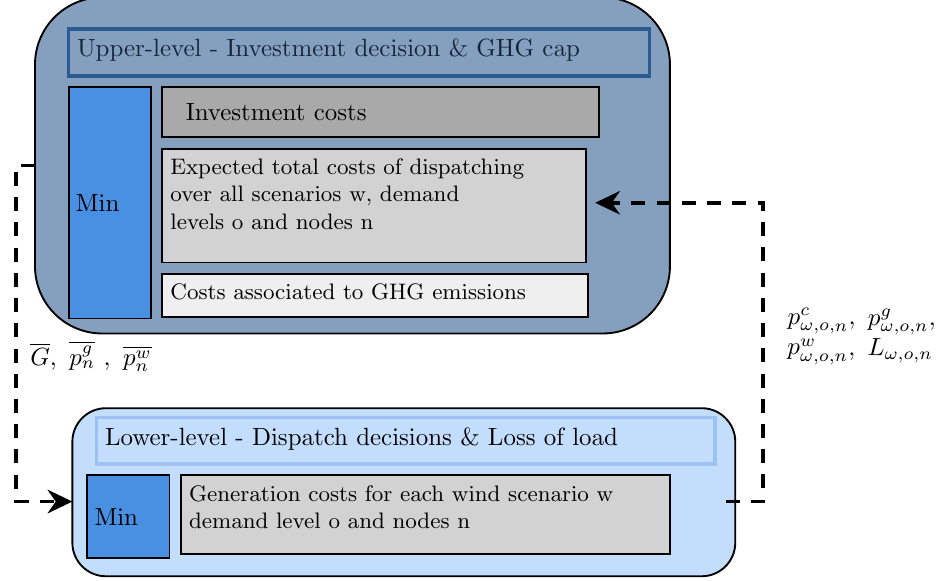
Figure 1. Schematic overview of the proposed model